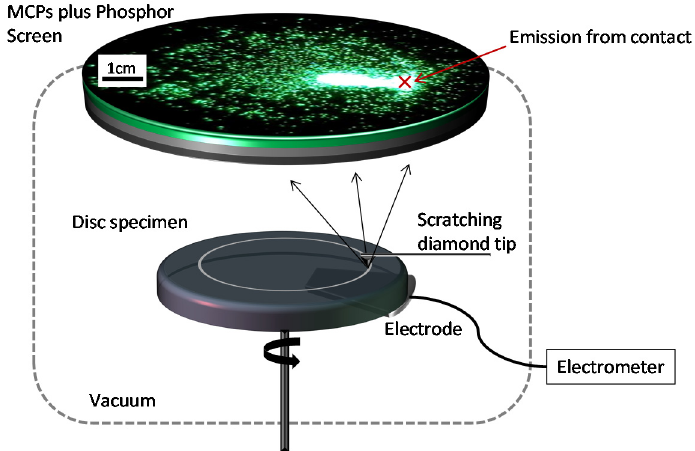
Figure 1. Schematic of the tribometer.